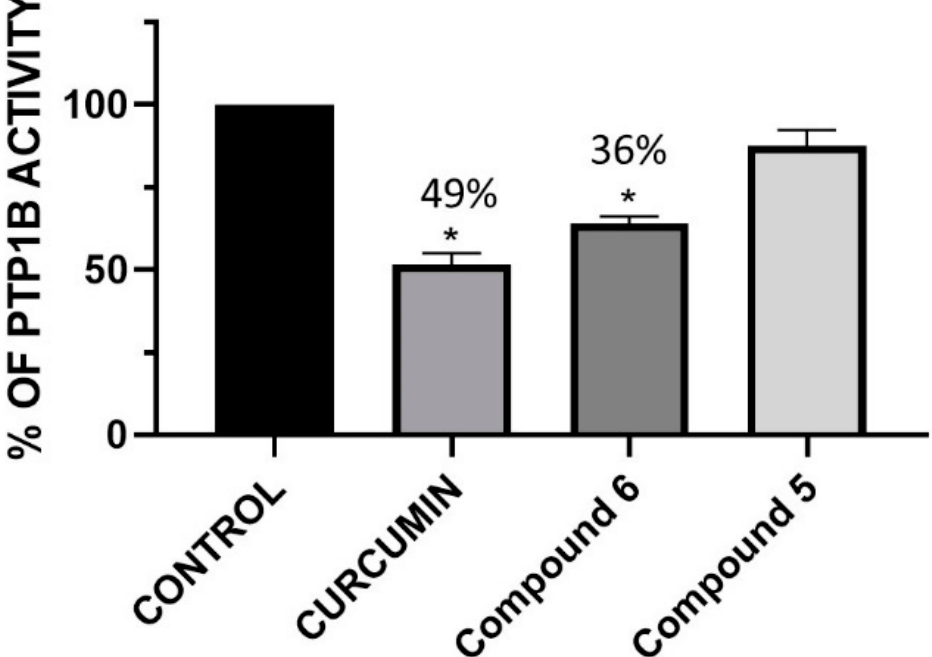
Figure 6. Enzymatic activity of PTP1B after 30 min of treatment with different concentrations of curcumin, compound 6 , and compound 5 . The results were presented as a percentage of control as means ± SD ( n = 3, * p < 0.0001).